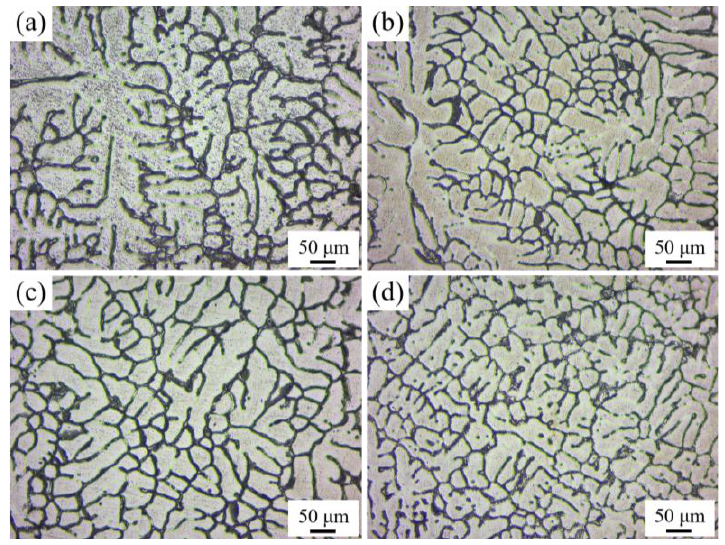
Figure 2. Optical micrographs of the as-cast alloys with different Ce contents ( a ) AL1; ( b ) AL2; ( c ) AL3; and ( d ) AL4.